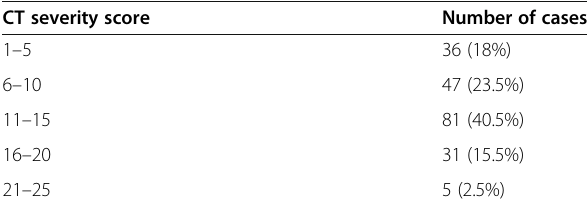
Table 4 Number and percent of cases in each severity score